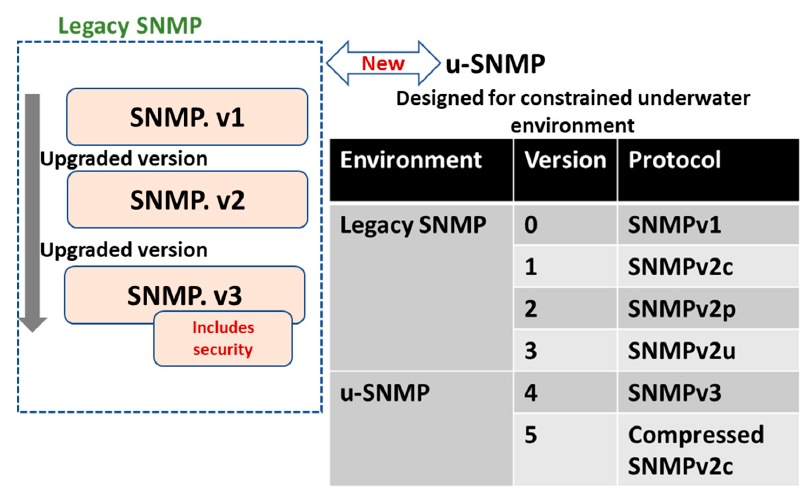
Figure 4. U-NMS components and request/response operation in IoUT [87].